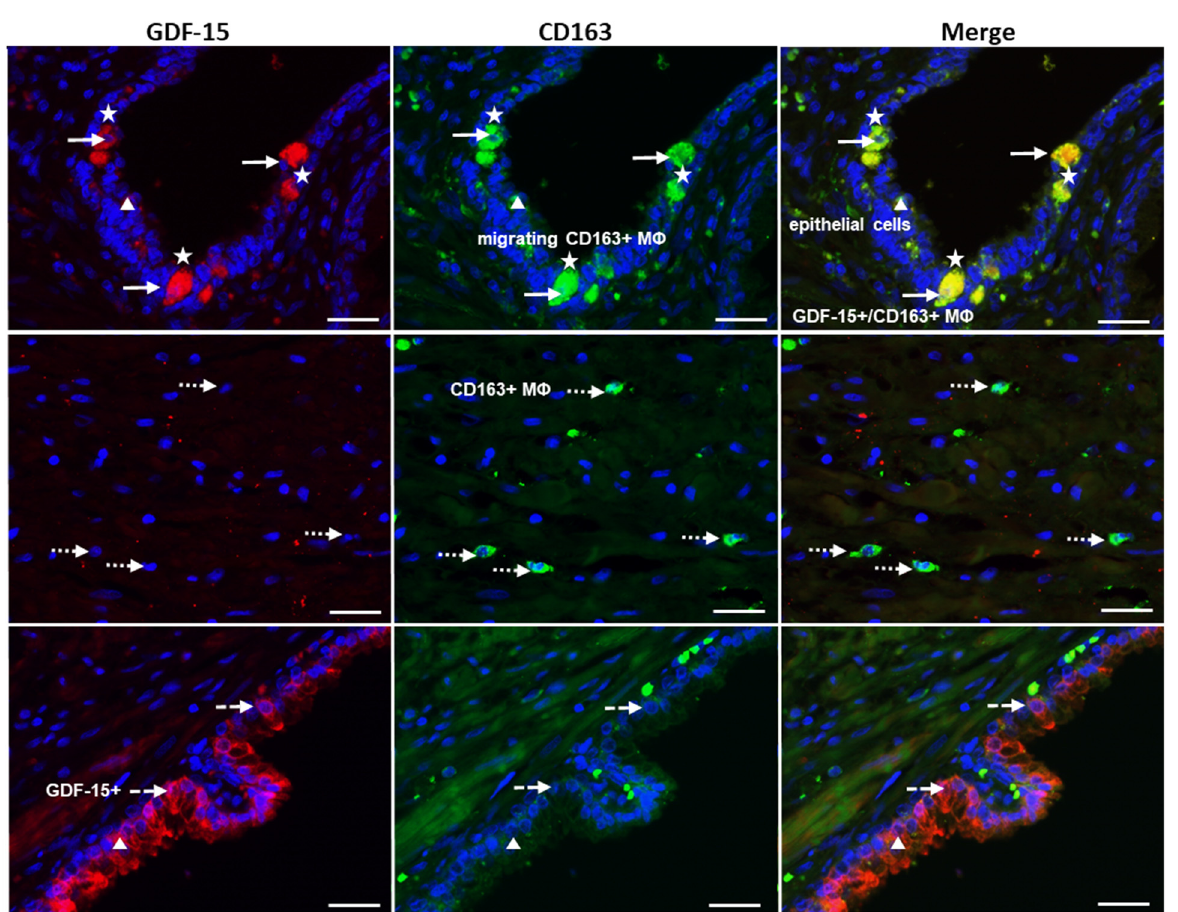
Figure 6. Double-immunofluorescence of PCa using GDF-15 (Cy3, red) and CD163 (Alexa Fluor ® 488, green) antibodies. White arrows indicate double-positive (GDF-15+/CD163+ M Φ ); white arrows with a dotted line mark single-CD163+ M Φ ; and arrows with a dashed line indicate single-GDF-15+; white stars mark transepithelial migrating CD163+ M Φ ; white triangles indicate epithelial lining cells of the prostate glands. Nuclei were counterstained with DAPI (blue); scale bar 100 µm.